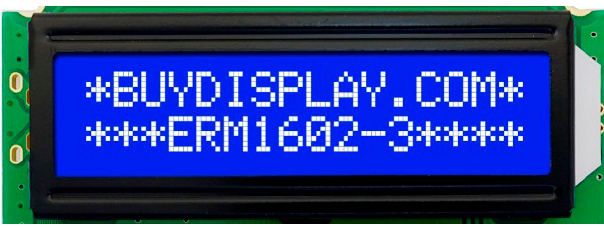
Figure 10. Gas shutoff device.